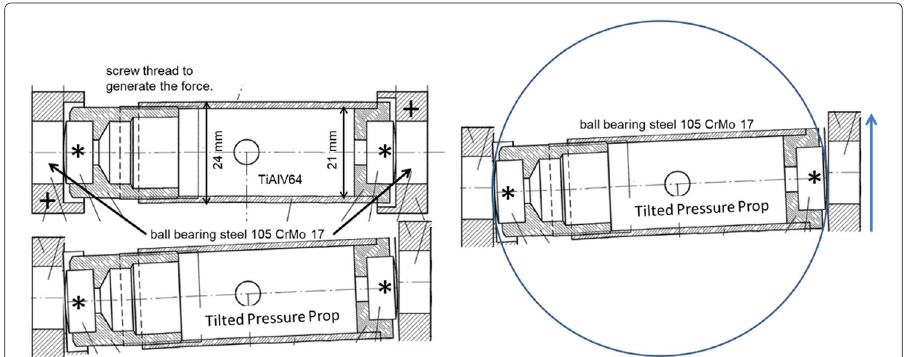
Fig. 16 Schematic view of the pressure prop at an outer suspension in the cryostat with the thin walled Titanium tube. Note the spherical sections at both ends (marked by *) from ball bearing steel. The full sphere for the roll of the pressure prop is indicated on the right. The support cup at the vacuum vessel stays fixed, while the cup on the Helium vessel moves with the shrinkage/expansion of the Helium vessel. The support cups are marked by +